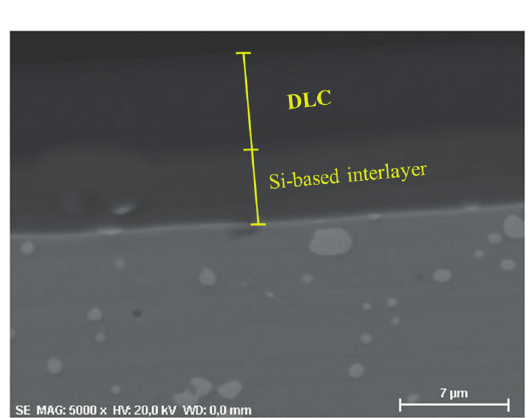
Figure 3: Surface roughness of (a) uncoated sample, (b) DLC film.